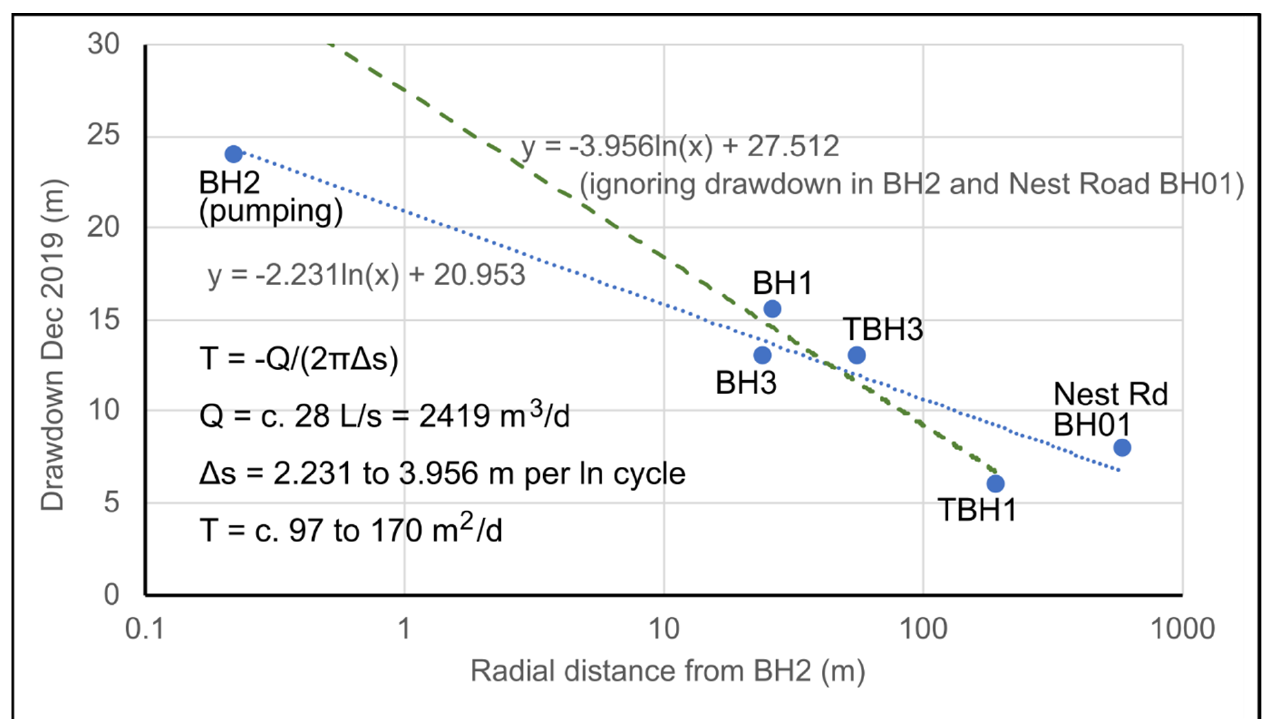
Figure 5. Drawdown versus log distance from BH2 for abstraction during December 2019, when a yield of 28 L/s is assumed. A drawdown at Nest Road BH01 of at least 8 m is assumed (RWL = +3–4 m asl and dynamic water level = − 4 to − 5 m asl, see Figure 9).